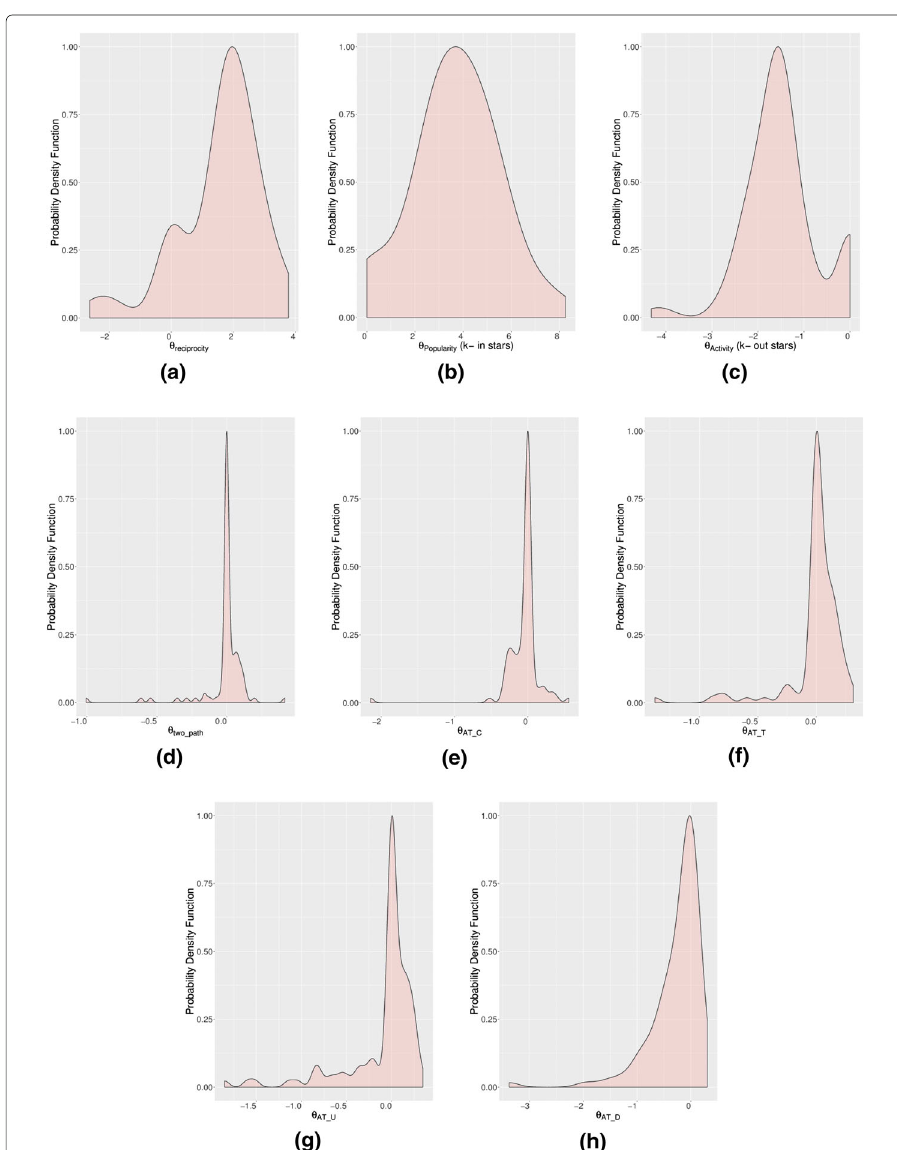
Fig. 2 The probability density functions of the estimated parameters (cid:2) for the endogenous attributes. Estimates were obtained for the 100 considered communities at the second level of the hierarchical structure of the Japanese production network. These graphs are used to illustrate the distribution of the